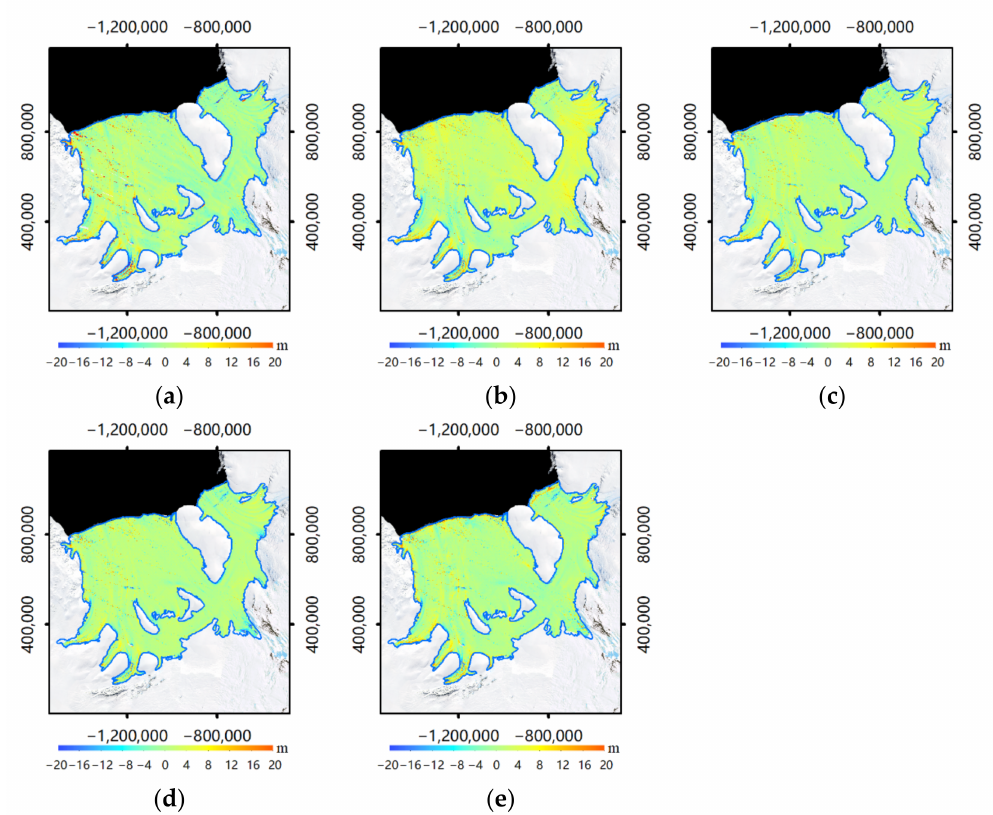
Figure 7. Distribution of elevation differences between the ICESat-2 FRIS DEM and five previously published Antarctic DEMs, i.e., REMA ( a ), TanDEM PolarDEM ( b ), Slater CryoSat-2 DEM ( c ), Helm CryoSat-2 DEM ( d ), Bamber DEM ( e ). Maps are in the polar stereographic projection in